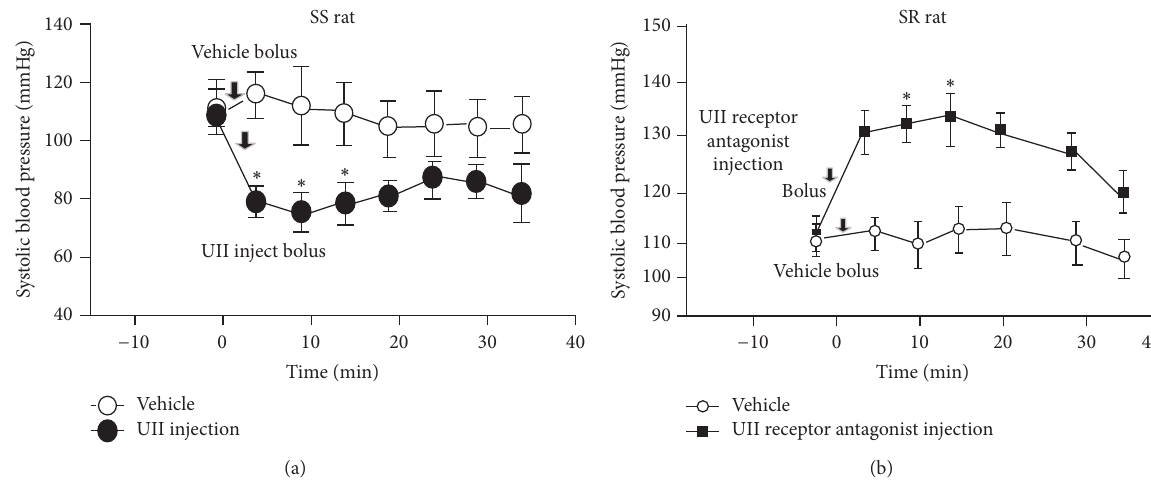
Figure 5: Figure 5 showed changes of systolic blood pressure in Dahl rats after UII and antagonist injected intravenously by bolus. UII (1nmol/kg) was injected intravenously by bolus in SS rats (a), while the antagonist (urantide) (10mmol/kg) was injected intravenously by bolus in SR rats (b). ∗ 𝑃 < 0.01 versus vehicle.